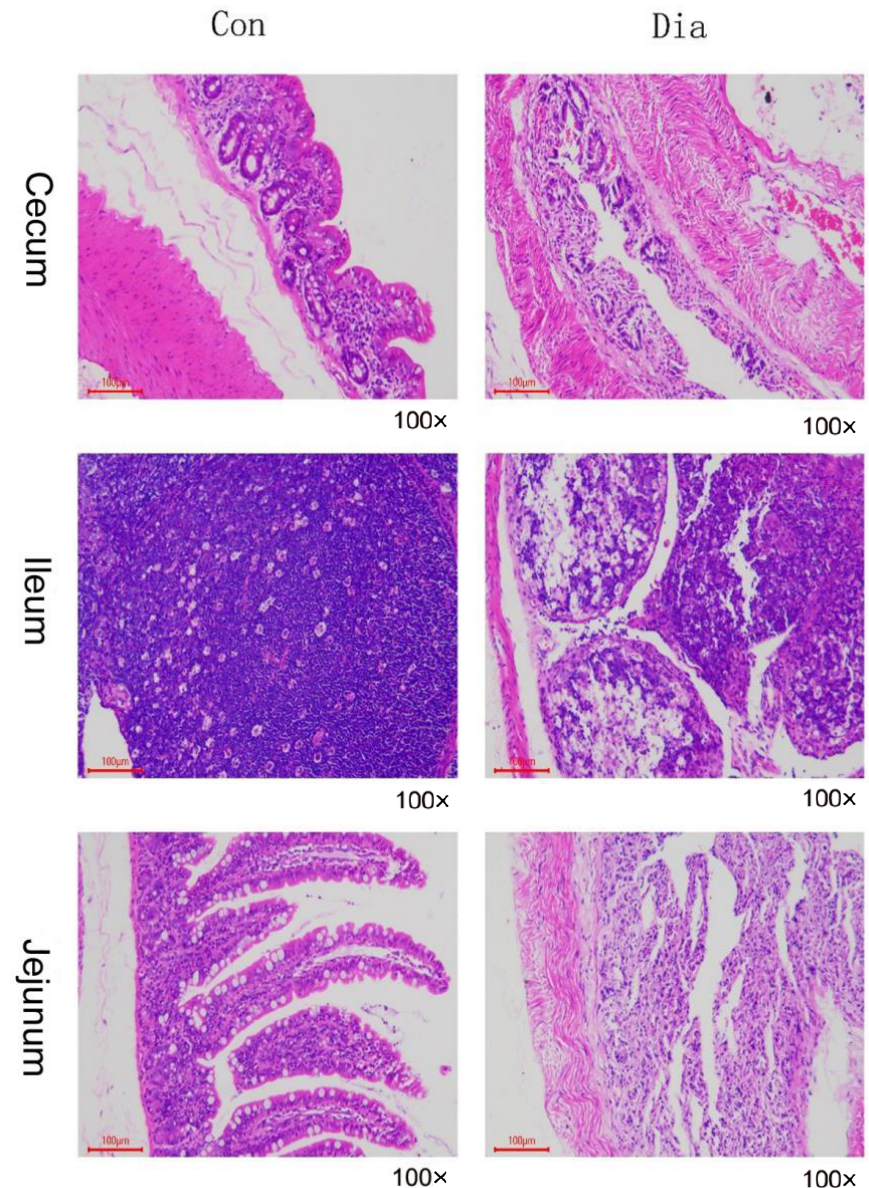
Figure 1. Normal rabbits’ (Con) and diarrhea rabbits’ (Dia) cecum, ileum, and jejunum tissue